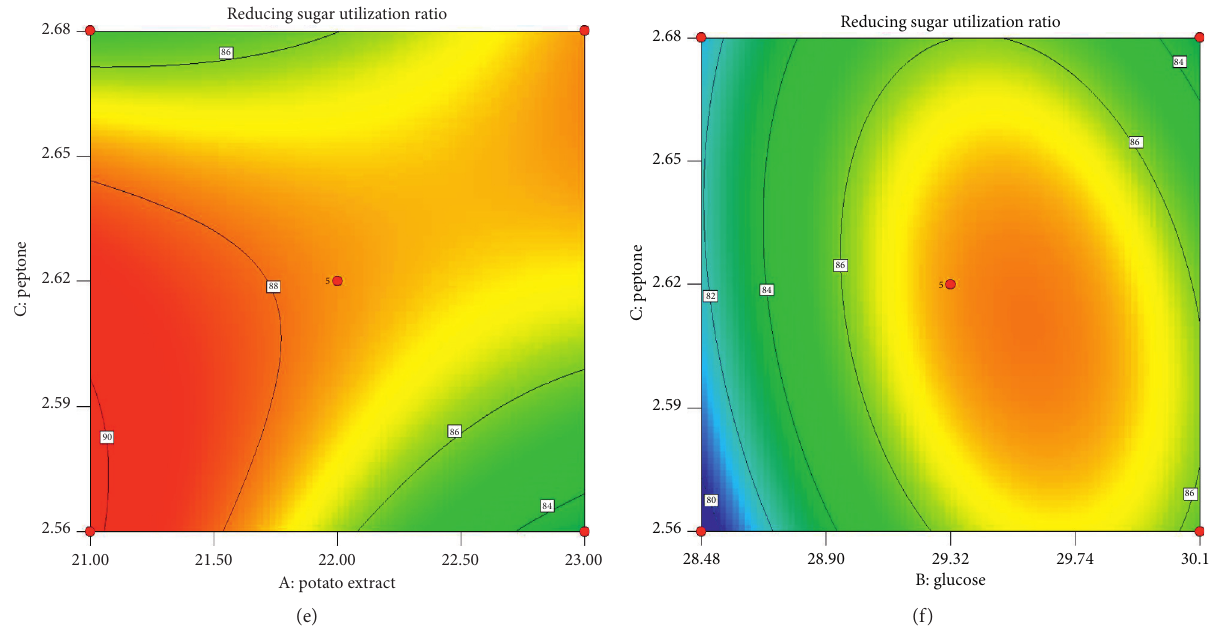
Figure 3: (a ∼ c) Contour plots of yield of FTP showing interactions between potato extract and glucose (a), potato extract and peptone (b), and glucose and peptone (c). (d ∼ f) The interaction effect of variables on reducing the glucose utilization ratio.